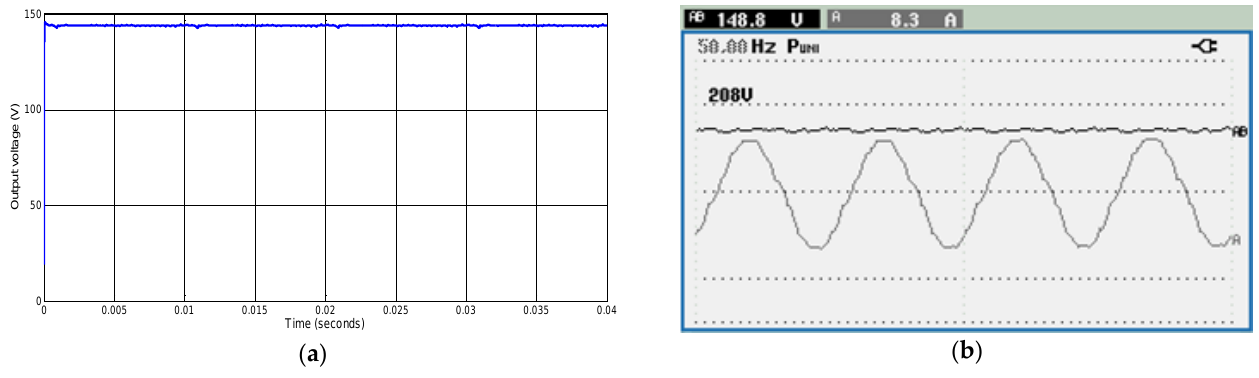
Figure 12. The 56-PR output voltage: ( a ) simulation results, ( b ) experimental results.